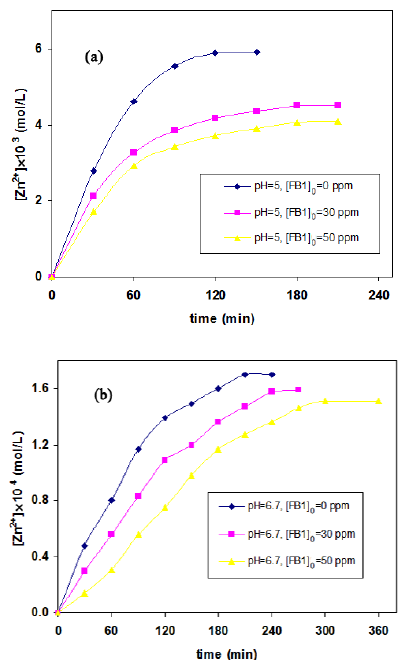
Figure 5. Evaluation of the Zn 2 + concentration produced by photodecomposition of ZnO at two pH values of ( a ) 5 and ( b ) 6.7 across varying FB1 concentration levels under UV irradiation; [FB1] 0 = 0, 30, and 50 mg / L, [ZnO] = 1.2 g / L, and T = 25 ◦